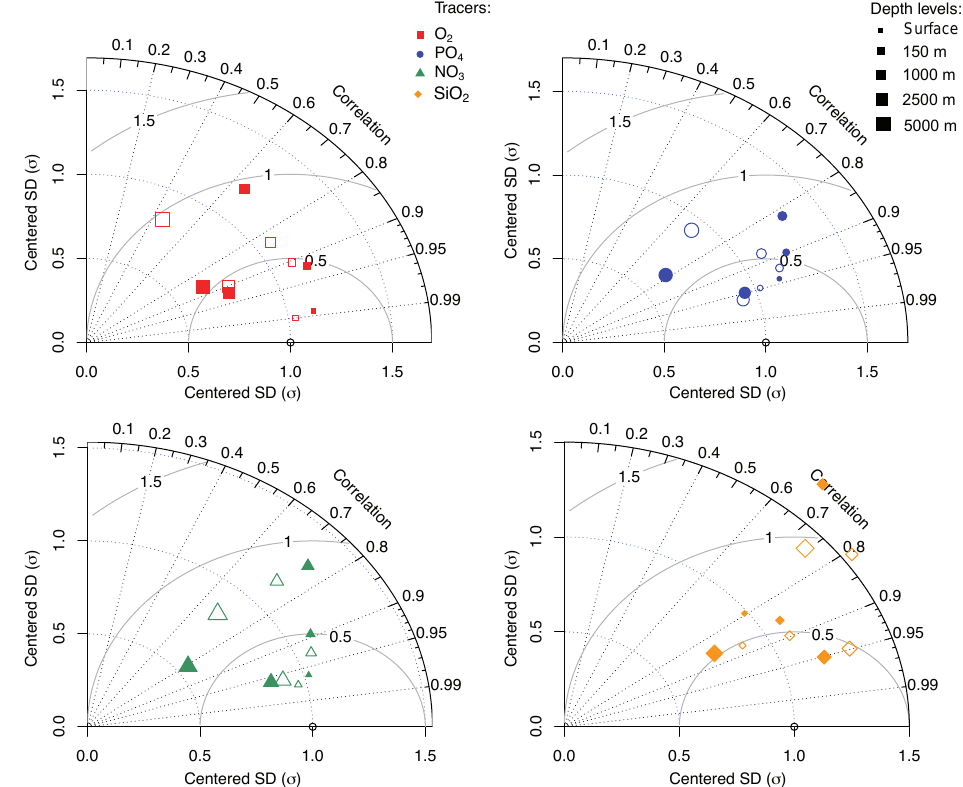
Figure 14. Taylor diagrams showing the correspondence between model results and observations for CNRM-ESM1 and CNRM-CM5.2 (Séférian et al., 2013). Climatological distribution over 1986–2005 of simulated oxygen (O 2 ) , phosphate (PO 4 ) , nitrate (NO 3 ) and silicate (SiO 2 ) concentrations are assessed against WOA2013 data product. Filled and empty symbols indicate skills for CNRM-ESM1 and CNRM- CM5, respectively. The size of the symbols indicates the depth at which statistics have been